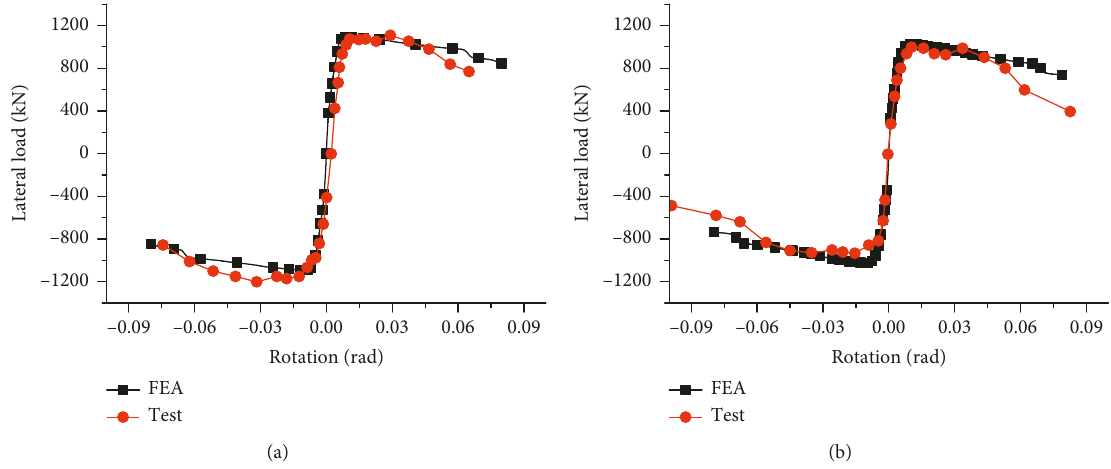
Figure 9: Comparison of experimental and numerical skeleton curves. (a) Specimen Beam1. (b) Specimen